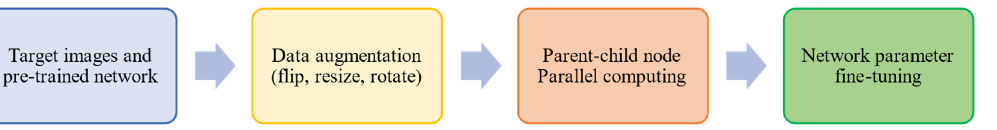
Figure 1. The overall flowchart of the method. The pretrained ResNet50 or VGG19 model and the target data which are X-ray images are received. Then, new data is generated using data augmentation steps. To speed up the network training, the input dataset is divided into portions and each child node is trained on that data portion. Finally, network parameters are optimized for the target data.